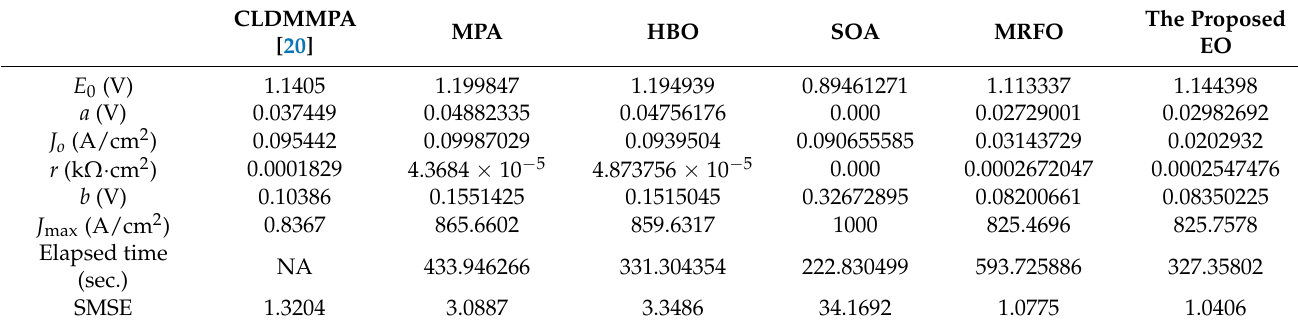
Table 7. The optimal parameters of SOFC dynamic-state based model operated at 1273 K.